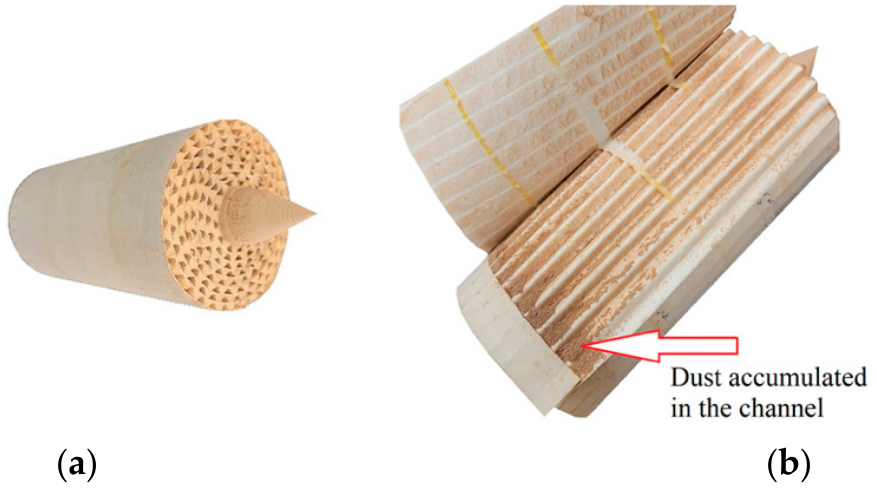
Figure 17. PowerCore filter after testing: ( a ) inlet view, ( b ) view of exposed channels.